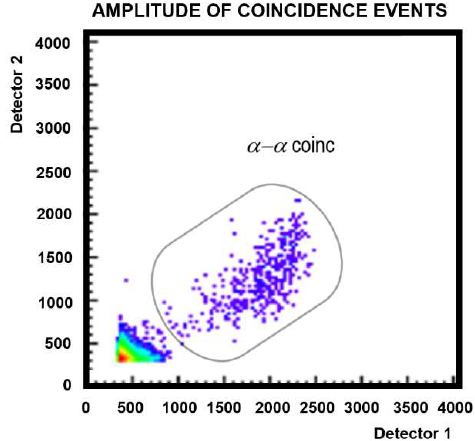
Fig. 5. Correlation plot ,  coincidences locus shows up fully separated with respect to the  and n -induced background on Silicon-pads and detector frame.